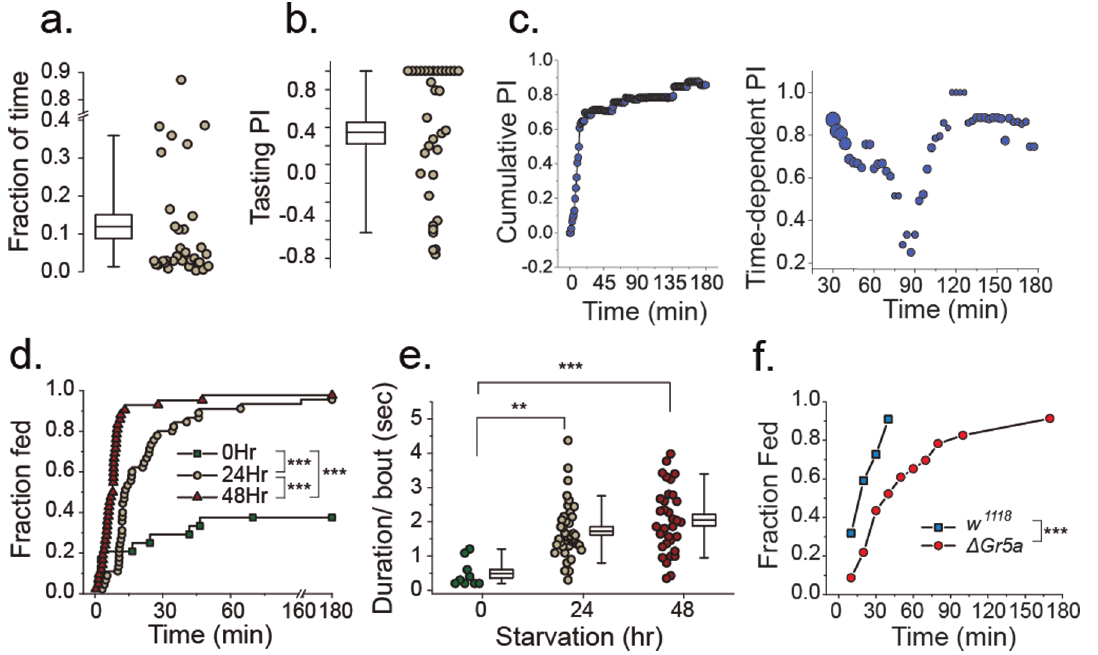
Figure 3. New types of behavioral inference from the FLIC system. (A) Flies spent 10% of their time in behaviors we categorized as tasting two foods prior to making their first meal choice. Fraction of time is calculated based on ‘‘total time spent tasting/time until the first meal’’. (B) A greater fraction of tasting events were directed toward the food the flies choose to consume (mean Tasting PI=0.35). A Tasting PI=1 implies a fly tasted a single food before ultimately consuming that food. A Tasting PI= 2 1 implies that a fly tasted a single food before ultimately consuming the opposite food. (C) While a cumulative preference index (left panel) is effective at portraying overall feeding tendencies, time-dependent preference indices (right panel) reveal subtle differences in behavioral choices as the experiment progresses. Flies exhibited a strong preference toward 10% sucrose in the first 30 min, which was attenuated in later time periods then returned to a strong preference (N=34; the size of the symbol is proportional to the sample size contributed to calculate PI in a given period). (D) Flies with increased feeding motivation (through longer periods of starvation) experienced their first meal earlier than control flies. Flies starved for increasing periods (0 hr, 24 hr, or 48 hr) exhibited reduced latencies until their first feeding event. Latency curves were found to be significantly different via log-rank test. (E) Flies with increased hunger (through longer periods of starvation) exhibited meals that were of significantly longer duration than control flies (One-way ANOVA followed by post-hoc test using a Bonferroni correction). (F) Taste input plays a role in motivation by decreasing latency to the first meal. Flies with loss of function in the trehalose receptor, D Gr5a , were significantly delayed in their first meal of a liquid trehalose food compared with control animals (log-rank test). **P # 0.01; ***P #